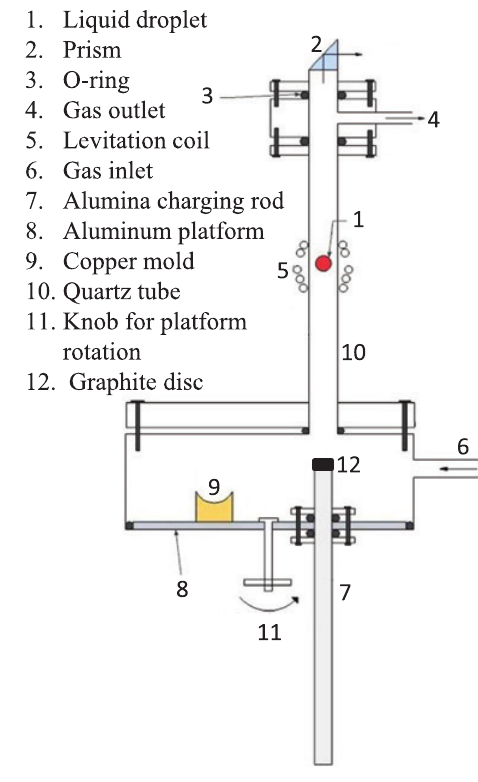
Fig. 1: Schematic diagram of the electromagnetic levitation